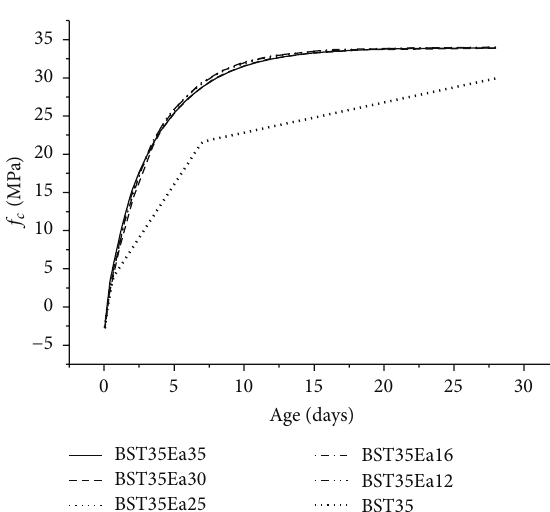
Figure 13: Simulation development of compressive strength with variation of energy of activation and experimental curves of sand concrete heat treated at 70 ∘